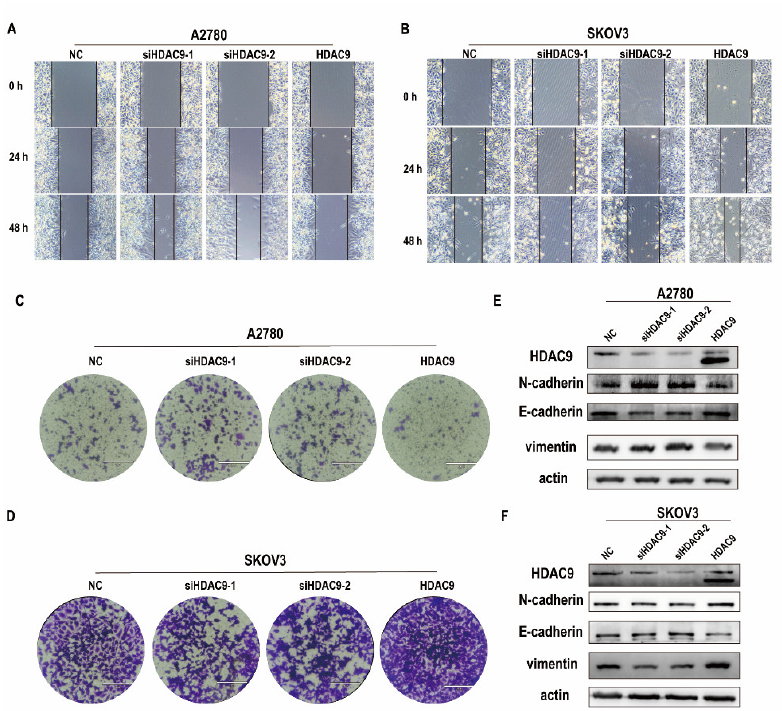
Figure 3. HDAC9 is involved in cell motility, invasion, and epithelial–mesenchymal transition (EMT) of ovarian cancer cells. A2780 and SKOV3 cells were transfected with a HDAC9 overexpression construct, HDAC9-shRNA plasmids (siHDAC9-1/2), or empty vector for 24 h. ( A , B ) Wound healing assays at indicated time points in A2780 and SKOV3 cells, the experiment was repeated three times. ( C , D ) Transwell migration assays in A2780 and SKOV3 cells (bar = 200 um), the experiment was repeated three times. ( E , F ) The expression of HDAC9, N-cadherin, E-cadherin, and vimentin in A2780 and SKOV3 cells was measured by Western blot.